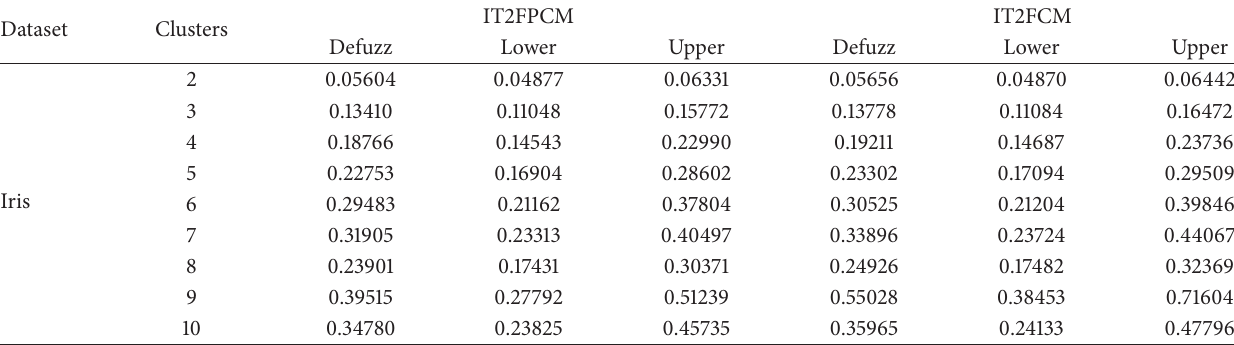
Table 11: Results of the IT2XB validation index to Iris Flower dataset clustering using IT2FPCM and IT2FCM algorithm with 𝑚 = [1.5, 2] and 𝜂 = [1.5, 2.5] as parameters.